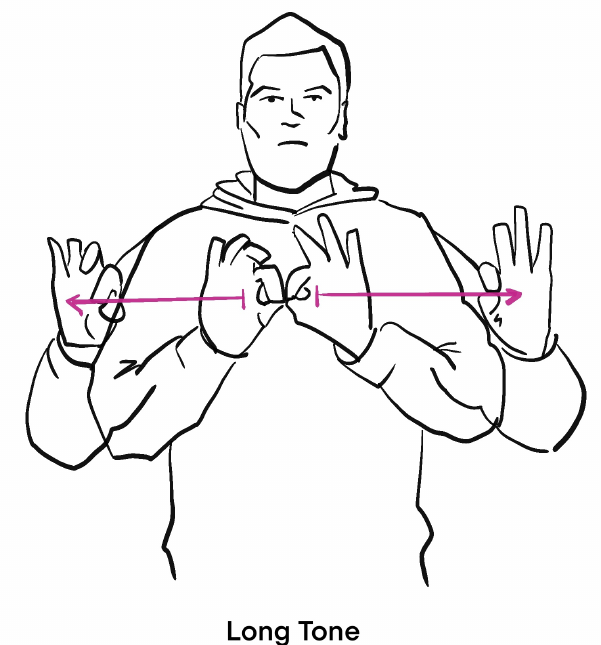
Figure 2. The long tone gesture in